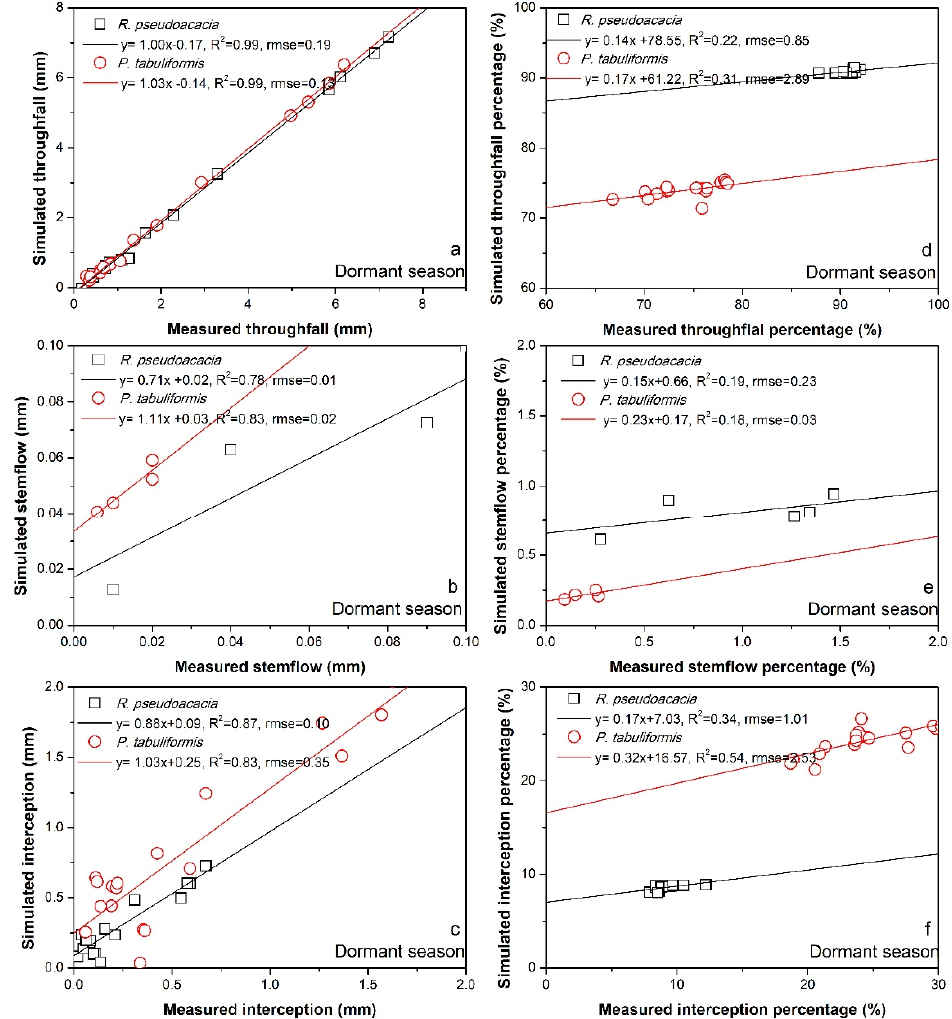
Figure 6. Comparison between the measured and simulated rainfall partitioning components for R. pseudoacacia ( a – c ) and P. tabuliformis ( d – f ) during the dormant season of 2016 .